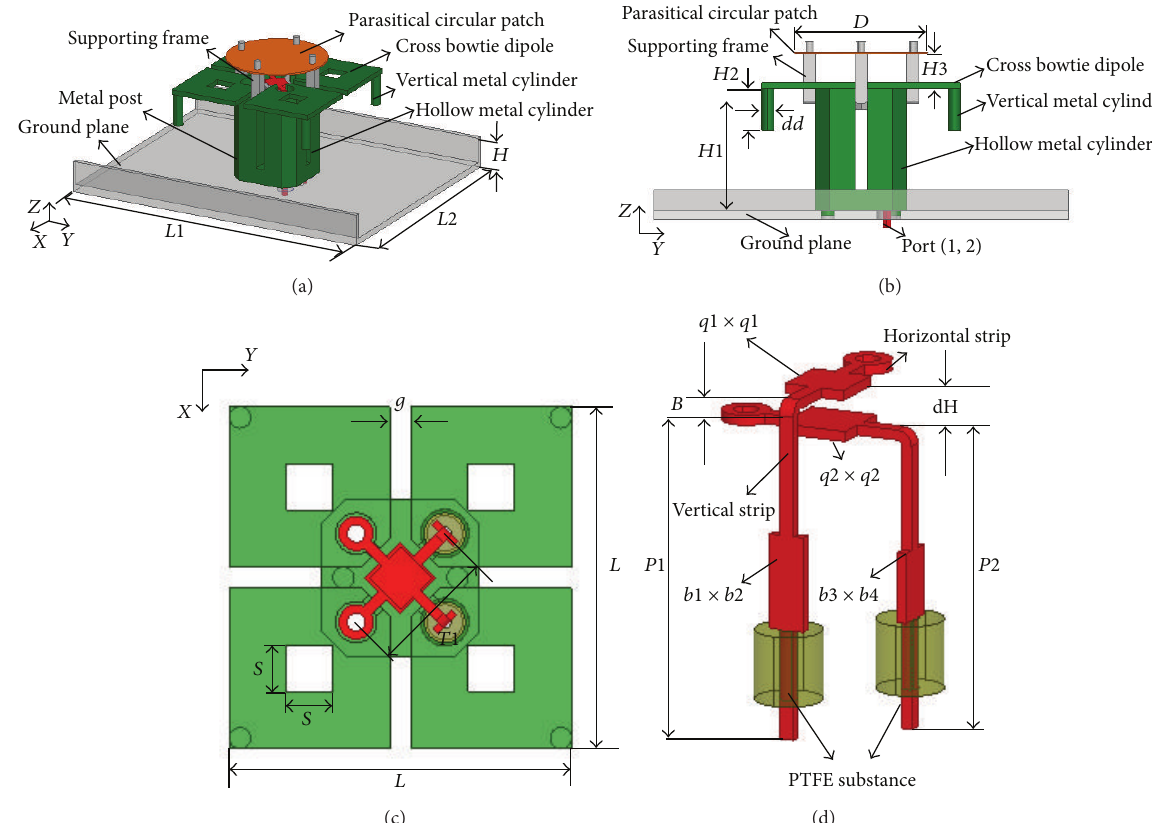
Figure 1: Geometry of the proposed design: (a) 3D view; (b) side view; (c) detailed view of the cross bowtie dipole; (d) detailed view of the feed strips.